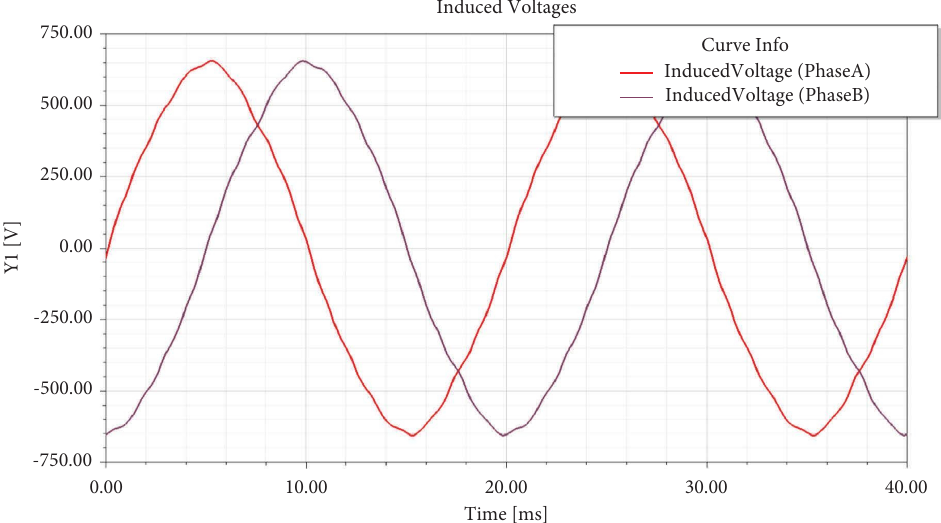
Figure 17: Back EMF curves of 4-pole 18-slot